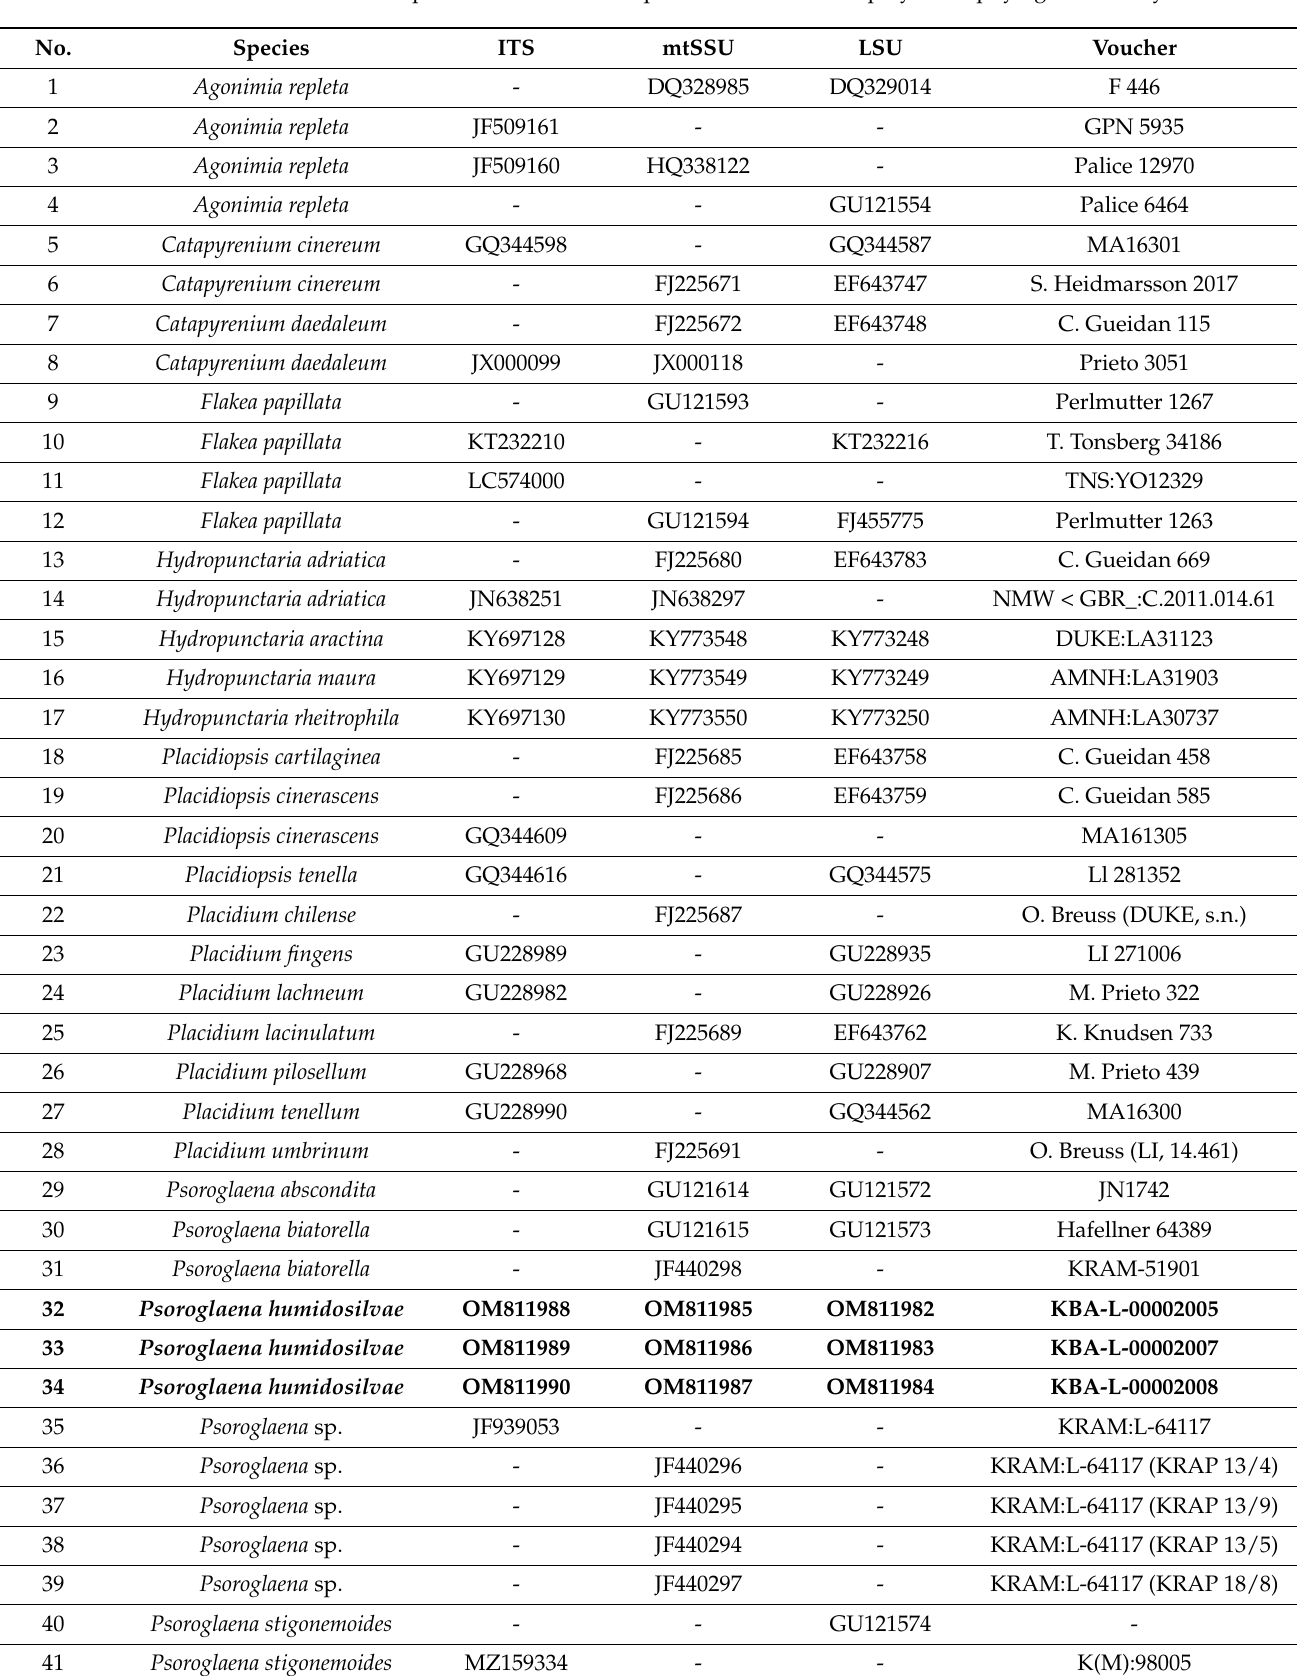
Table 1. Species list and DNA sequence information employed for phylogenetic